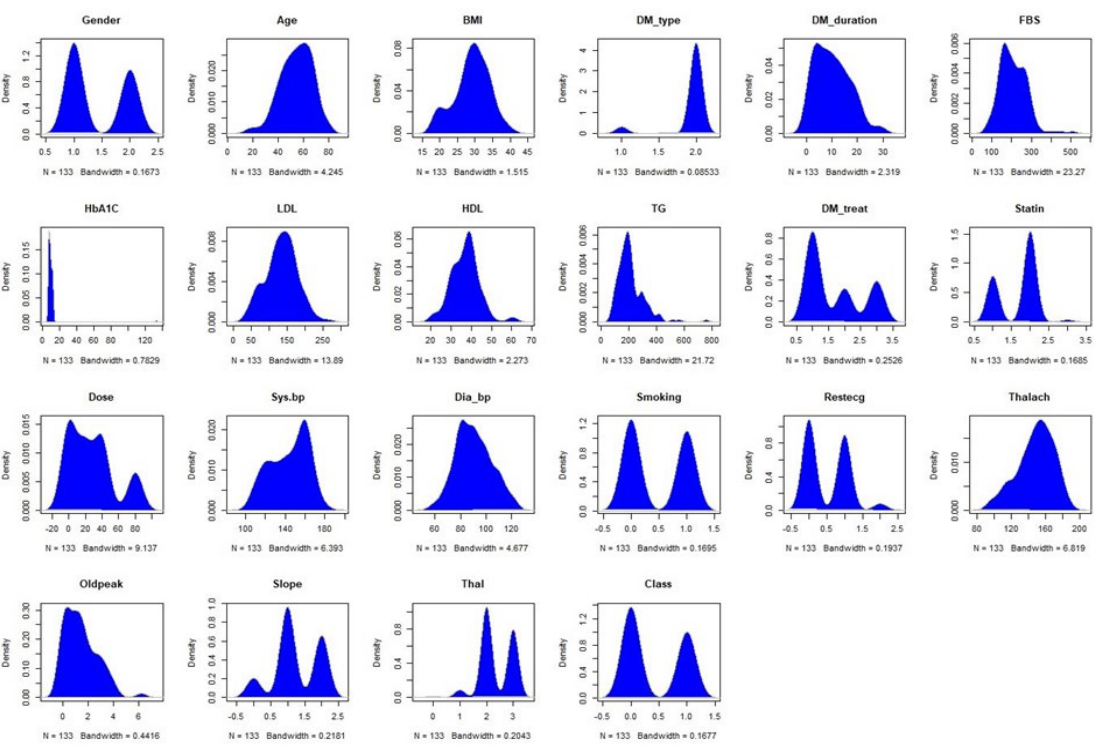
Figure 1. Density plot of attributes in the